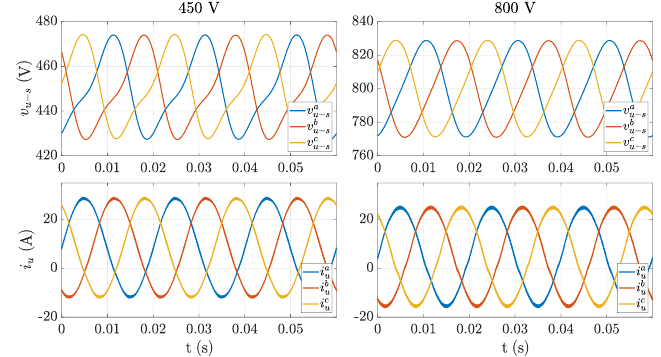
Figure 5. Cell voltages and arm